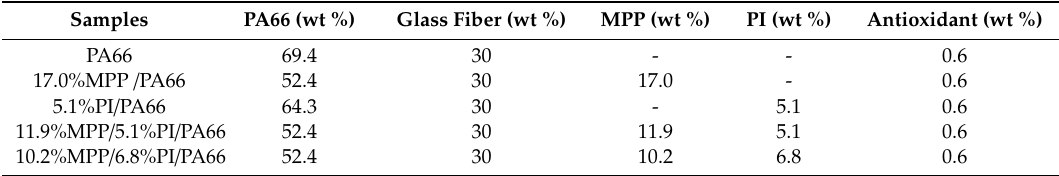
Table 1. Formulae of flame-retardant PA66